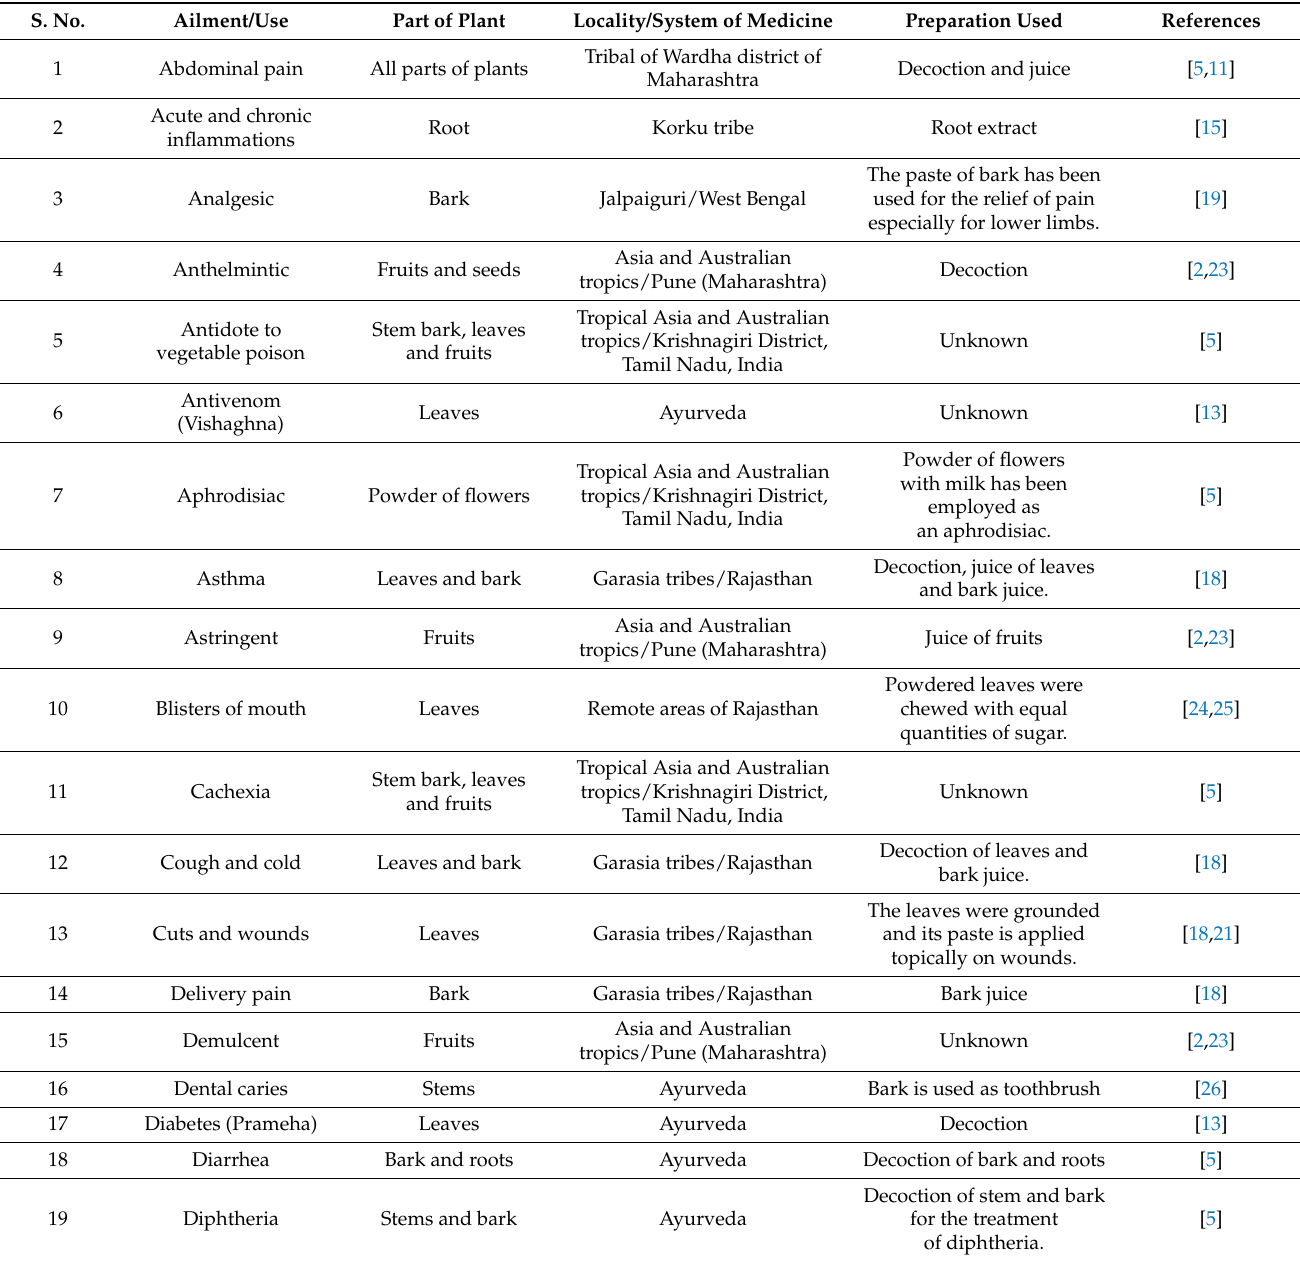
Table 1. Local and contemporary uses of E. laevis